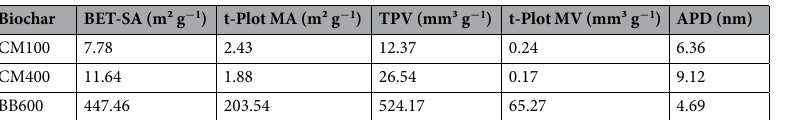
Table 2. Surface area and porous structure of biochars. BET-SA: BET-surface area; t-Plot MA: t-Plot micropore area; TPV: total pore volume; t-Plot MPV: t-Plot micropore volume; APD: adsorption average pore diameter (4 V/A by